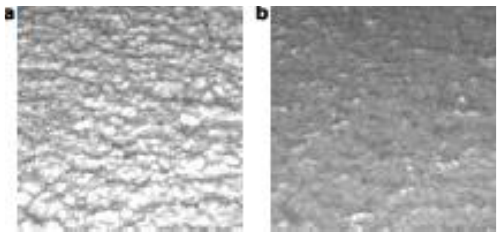
Figure 6. Subfigures ( a , b ) are cropped image with presence and absence respectively of floating olive oil over the olive paste [7].